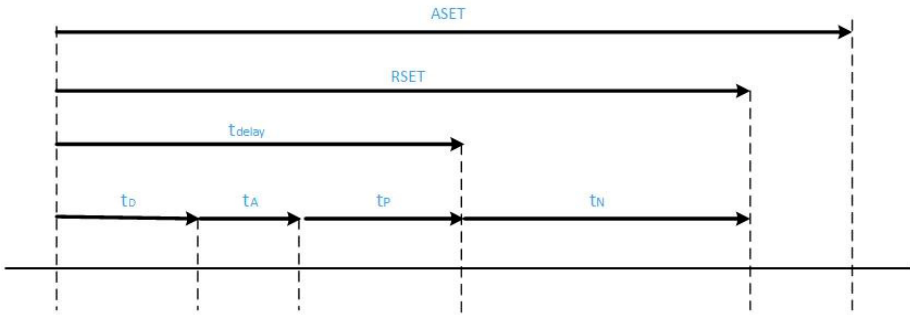
Figure 6. Distribution of evacuation time.